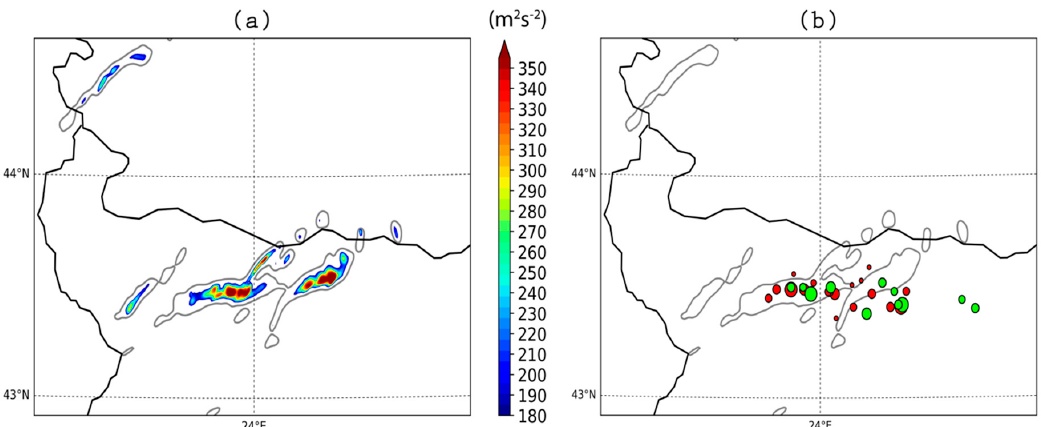
Figure 18. ( a ) Swaths of hourly-maximum 2–5 km UH (color shading) simulated in member 30 from WRF.15may00utc during the 10:00–14:30 UTC time period. The UH = 75 m 2 s − 2 contour is also overlaid in gray to better highlight the origin of the simulated supercells. ( b ) Comparison of the forecasted UH swaths against hail reports from NIMH/Hail Suppression Agency (HSA) (red dots) and ESWD (green dots). The size of the dots is proportional to the size of the reported hail, with the smallest/largest dots corresponding to hail diameters of 0.5 and 7 cm, respectively. Note that the UH = 75 m 2 s − 2 contour has been smoothed using a Gaussian filter with a standard deviation of 1.5 km.